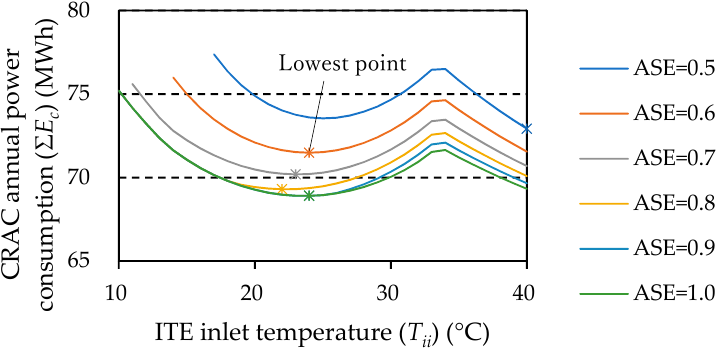
Figure 20. Annual power consumption of CRAC ( Σ E c ) versus ITE inlet temperature ( T ii ).